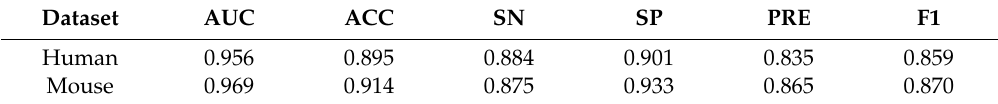
Table 4. The performances of PredLnc-GFStack on Human-Main and Mouse-Main using 10-CV.